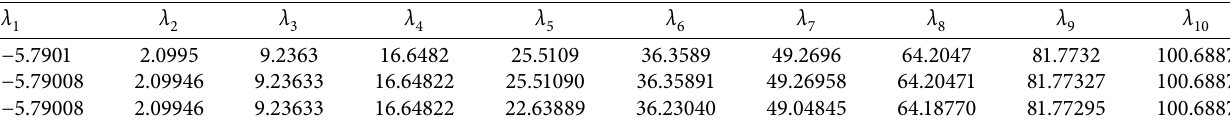
Table 3: For Example 4 with e � 5, for the frst ten eigenvalues comparing the present results (third row) to those obtained by Liu [6] 0 (second row) and the Lanczos algorithm (last row).